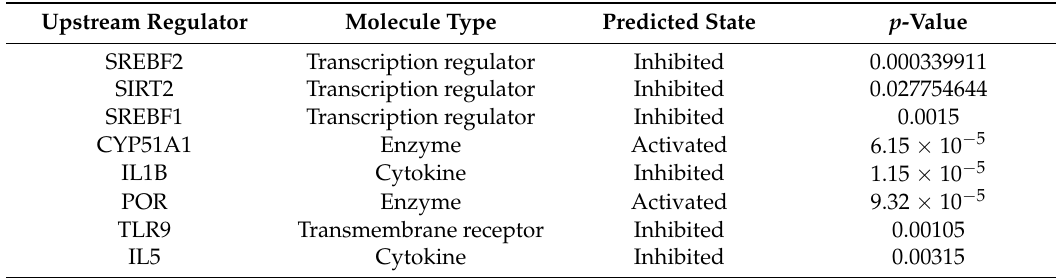
Table 5. The most activated and inhibited upstream regulators in GPO vs. CTR predicted by the Upstream Regulator Analysis in IPA.